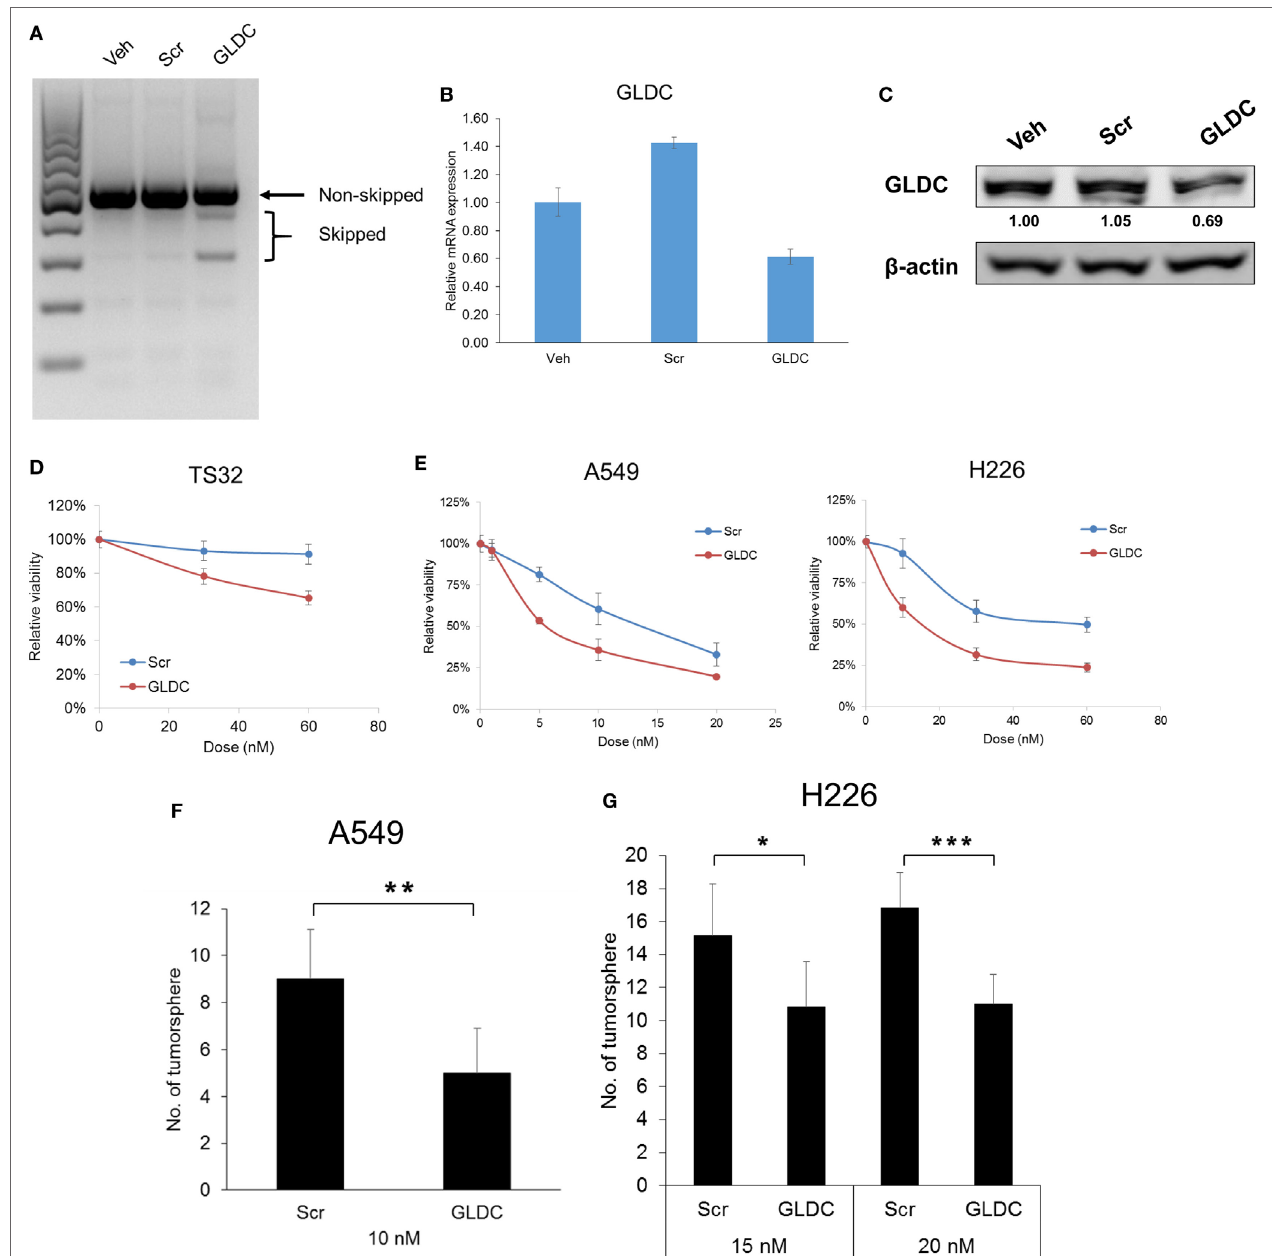
FigUre 2 | Glycine decarboxylase (GLDC) inhibition suppresses lung cancer cell growth and tumorigenicity. (a) Representative image of agarose gel electrophoresis of polymerase chain reaction (PCR) products. After treatment for 3 days, total RNA was harvested for cDNA synthesis followed by PCR amplification for exon skipping detection. (B) The mRNA expression of GLDC after steric hindrance antisense oligonucleotide (shAON) treatment. After 3-day treatment, total RNA was harvested for cDNA synthesis followed by qPCR assay. The data represent mean ± SD of triplicate PCR reactions. (c) The protein expression of GLDC after shAON treatment. After 3-day treatment, protein lysate was collected for western blot. The densitometry values were in relative to Veh after normalization to β -actin. The data are the best representative of three independent experiments. (D) MTS assay to show the effect of GLDC-shAON on cell proliferation. 3,000 TS32 cells were seeded into ultra-low attachment 96-well microplate followed by shAON transfection for 3 days. The data represent mean ± SEM of three independent experiments. (e) MTT assay to show the effect of GLDC-shAON on cell proliferation. 2,000 cells were seeded into 96-well microplate for overnight followed by shAON transfection for 3 days. The data represent mean ± SEM of three independent experiments. (F,g) Effect of shAON to tumorsphere formation in A549 and H226 cells. 200 cells were seeded into ultra-low attachment 96-well microplate followed by shAON transfection for 7 days. The data represent mean ± SD of five wells (* p < 0.05, ** p < 0.01, and *** p <